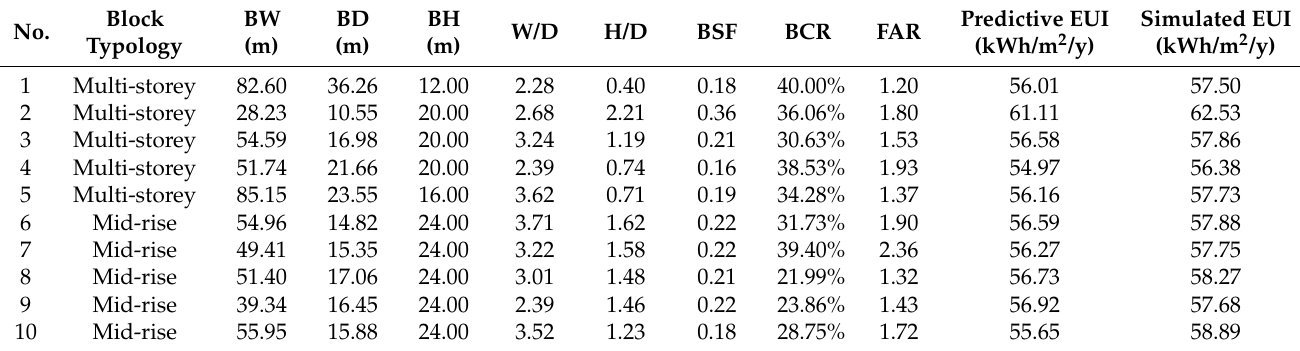
Table 6. Block morphological parameters and EUI of block samples for model